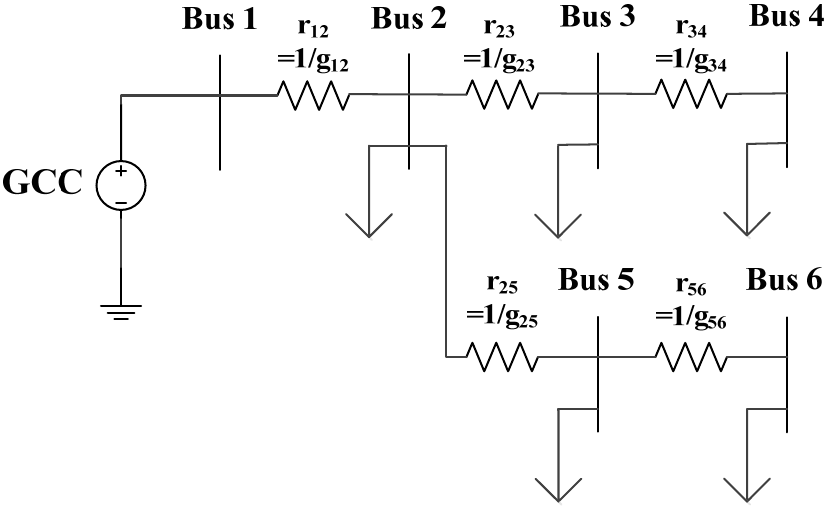
Figure 1. A simple radial DC distribution